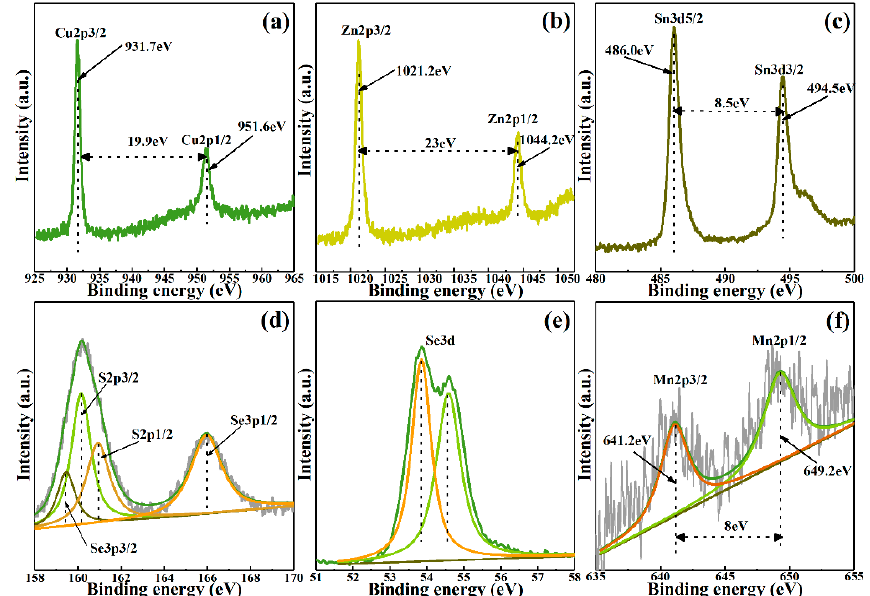
Figure 4. X-ray Photoelectron Spectroscopy (XPS) spectrum of Cu 2 Mn x Zn 1 − x Sn(S,Se) 4 ( x = 0.1) thin films: ( a ) Cu, ( b ) Zn, ( c ) Sn, ( d ) S, ( e ) Se, and ( f ) Mn.